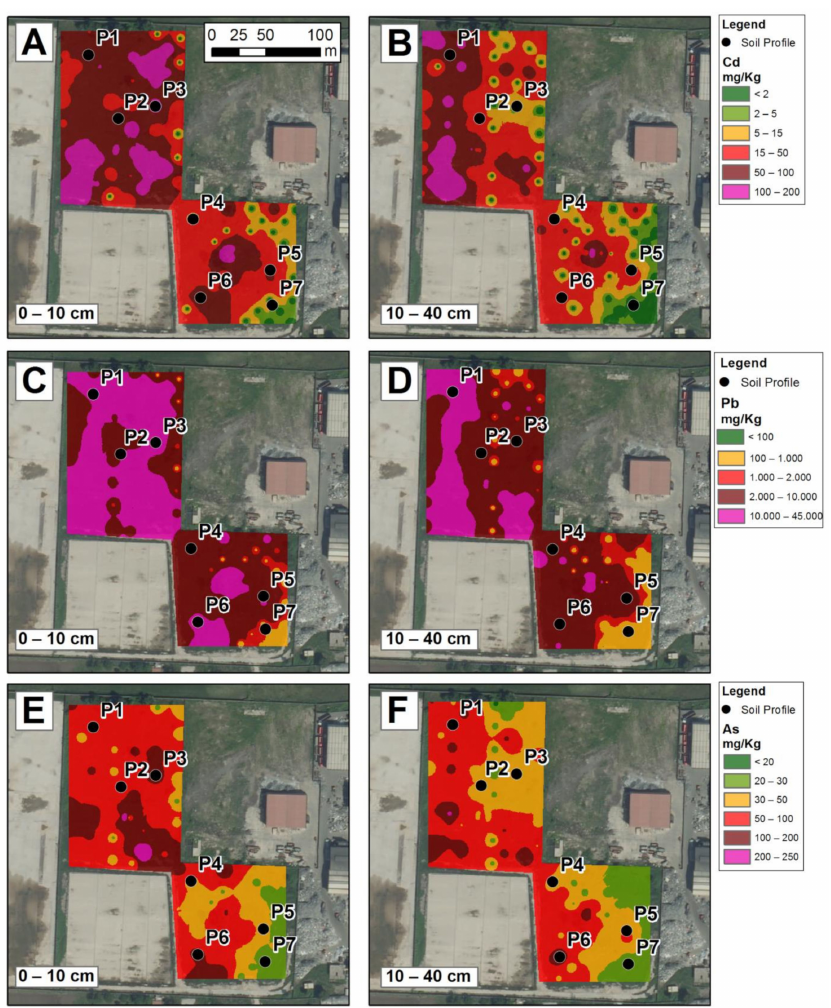
Figure 7. Maps of PTE distribution, measured by PXRF. ( A ) Cd at 0–15 cm; ( B ) Cd at 15–40 cm; ( C ) Pb at 0–15 cm; ( D ) Pb at 15–40 cm; ( E ) As at 0–15 cm; ( F ) As at 15–40